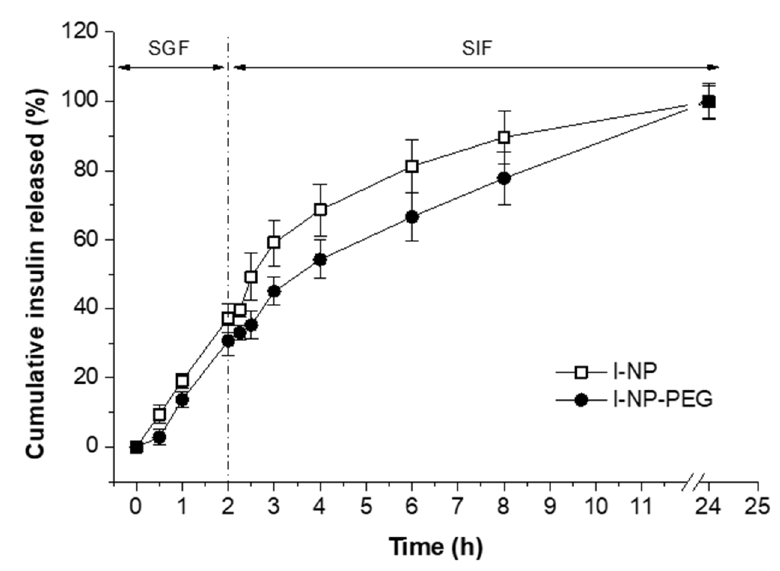
Figure 4. In vitro release behavior of insulin from I-NP and I-NP-PEG in SGF and SIF at 37 °C. Data presented as mean ± S.D. ( n = 3).